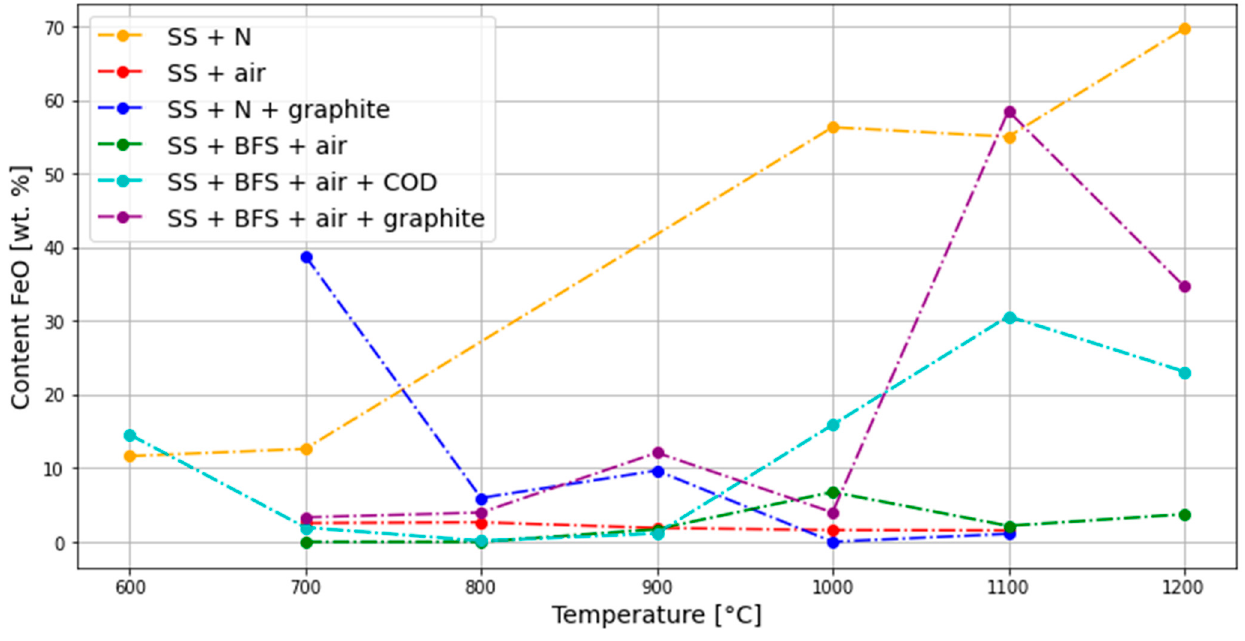
Figure 4. Effect of temperature, atmosphere and reducing element on FeO content in sludge.